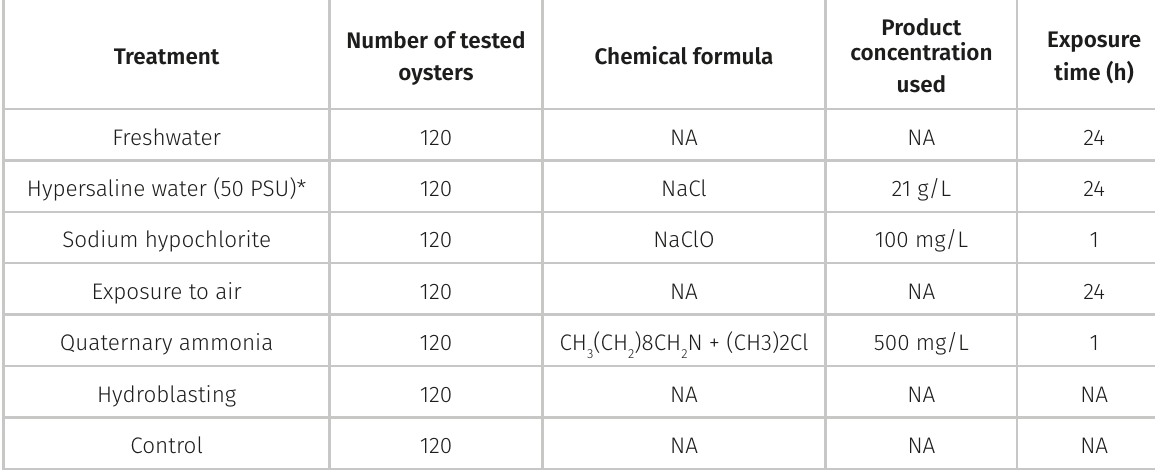
Table I. Treatments for reducing the colonization of oysters by epibionts. NA= Not applicable; (*) Obtained from the dissolution of refined iodized